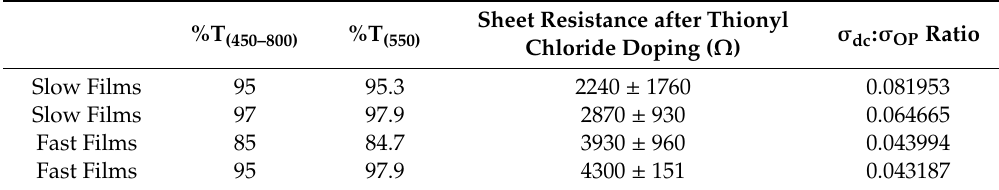
Table 5. σ dc : σ OP ratio calculations for slow and fast-filtered films of similar %T. Sheet resistance values calculated after a thionyl chloride